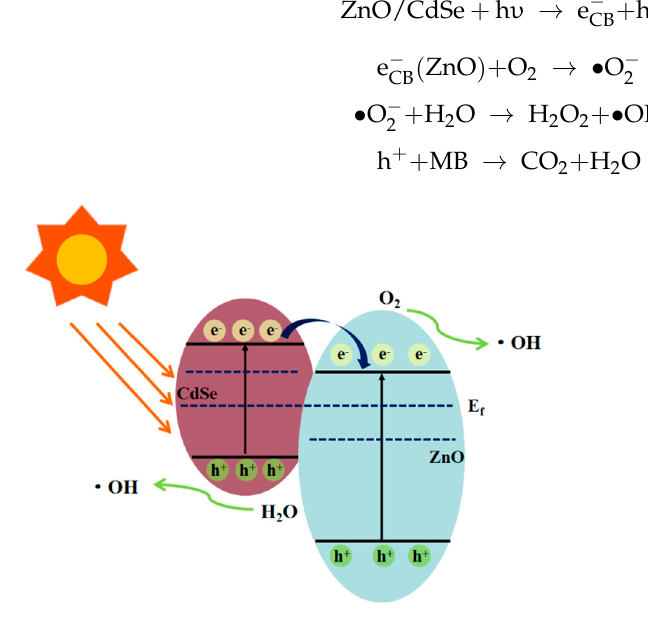
Figure 10. Photocatalytic mechanism of ZnO/CdSe − CC.